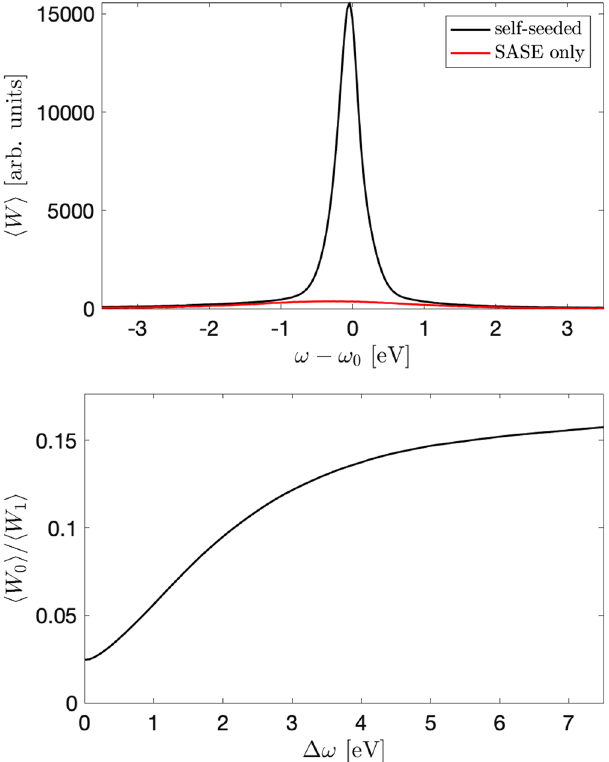
FIG. 6. Top: Averaged measured self-seeding spectrum at LCLS U15 undulator. With the seed blocked, the SASE from the second stage can be measured directly, and used to compute the contribution from the seed alone. Bottom: Measured average ratio of SASE to seeded energy versus bandwidth. independently by blocking the seed in the SXRSS system. The laser heater was set to 30 μ J, which is large enough to strongly suppress the microbunching-driven pedestal. The relative pure SASE amplitude is A 0 =A 1 ¼ 2 . 4% , and the SASE bandwidth is σ A 0 ¼ 1 . 15 eV using a Gaussian fit.